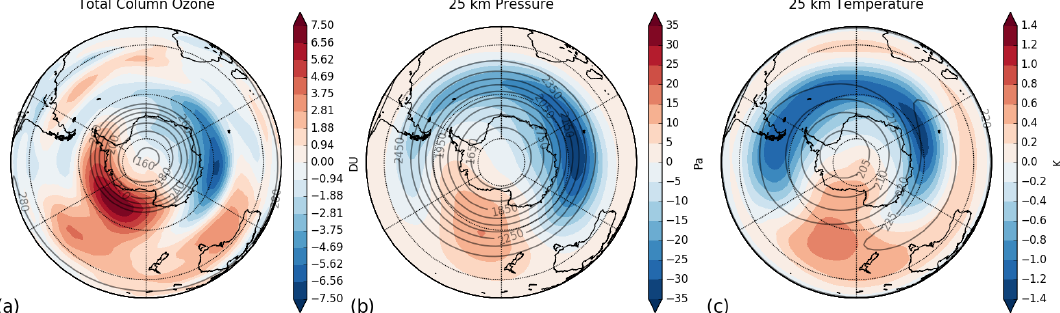
Figure 11. Maps of the average differences in October monthly mean total column ozone (a) (units of Dobson units), 25km pressure (b) (units of pascals) and 25km temperature (c) (units of kelvin) between the perturbed run and the control run, i.e. the difference between using T equal to either T UM − UKCA + (cid:49)T − (perturbation run with the parameterisation scheme on) or T UM − UKCA (control run with SSO the parameterisation scheme off). Also shown in each panel are the respective values from the control simulation using a value of T equal to T UM − UKCA